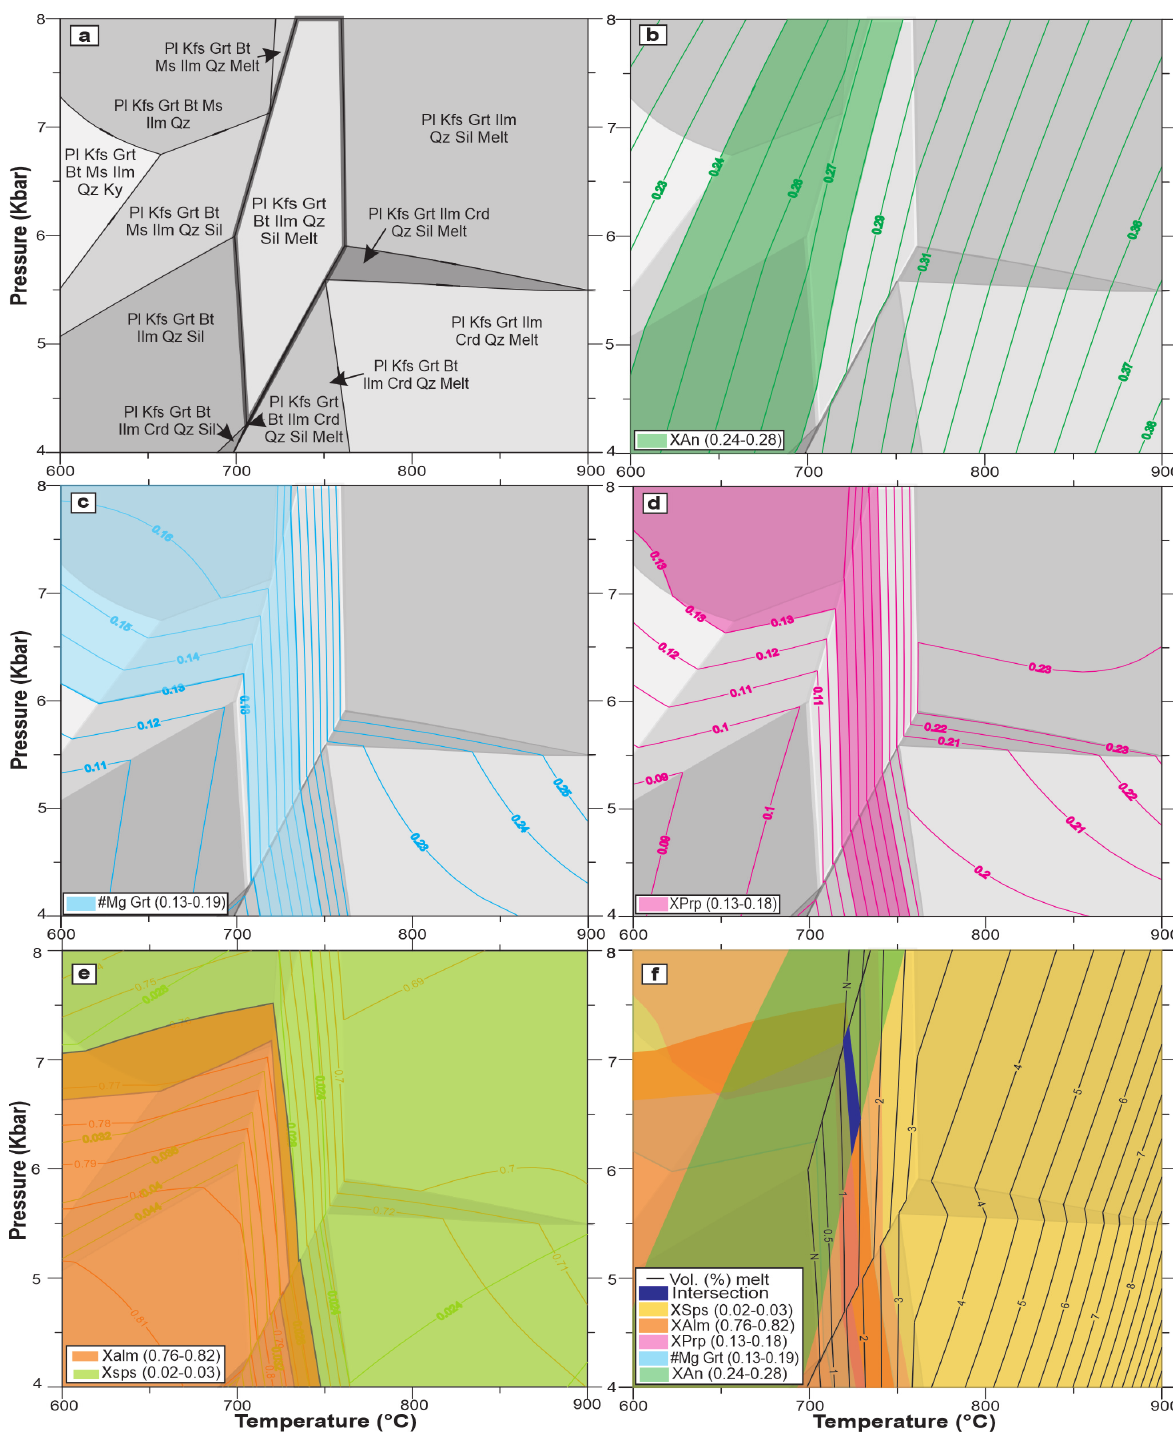
Figure 10. P–T pseudosection calculated using the bulk composition from sample CCS-25 (A fields showing the preserved assemblage Kfs+Pl+Qz+Grt biotite. (c) Plots of Mg# in garnet. (d) Plots of X on the use of overlapping ranges of phase